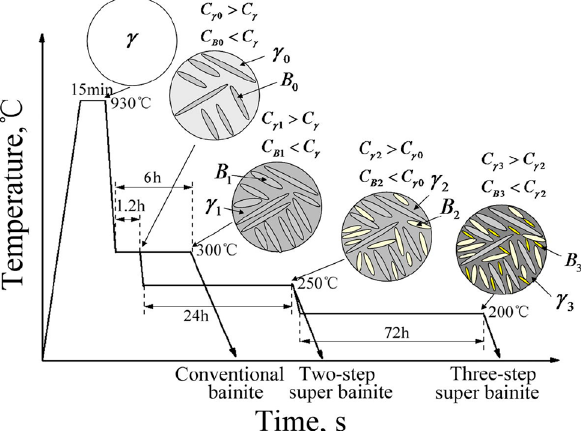
Figure 3. Heat treatment cycles and resultant microstructures during a multi-step low-temperature super-bainite transformation. Extracted from reference [24]. Reproduced with permission from Elsevier, 2017.